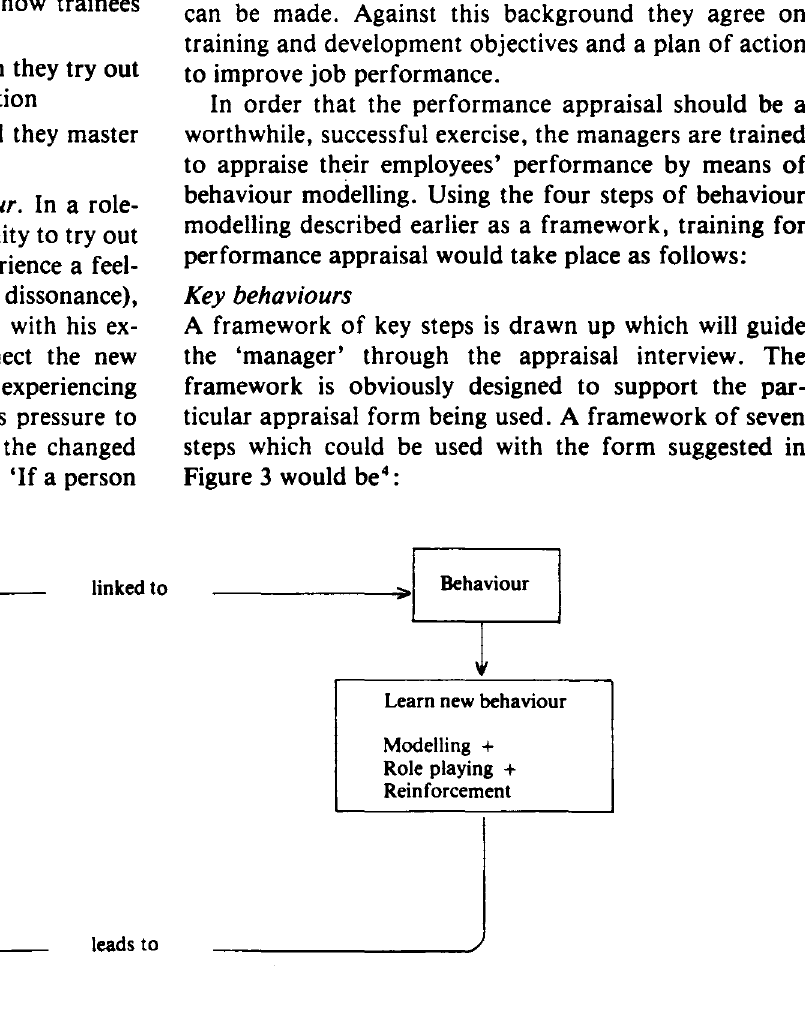
Fig. 2 Goldstein and Sorcher's revised